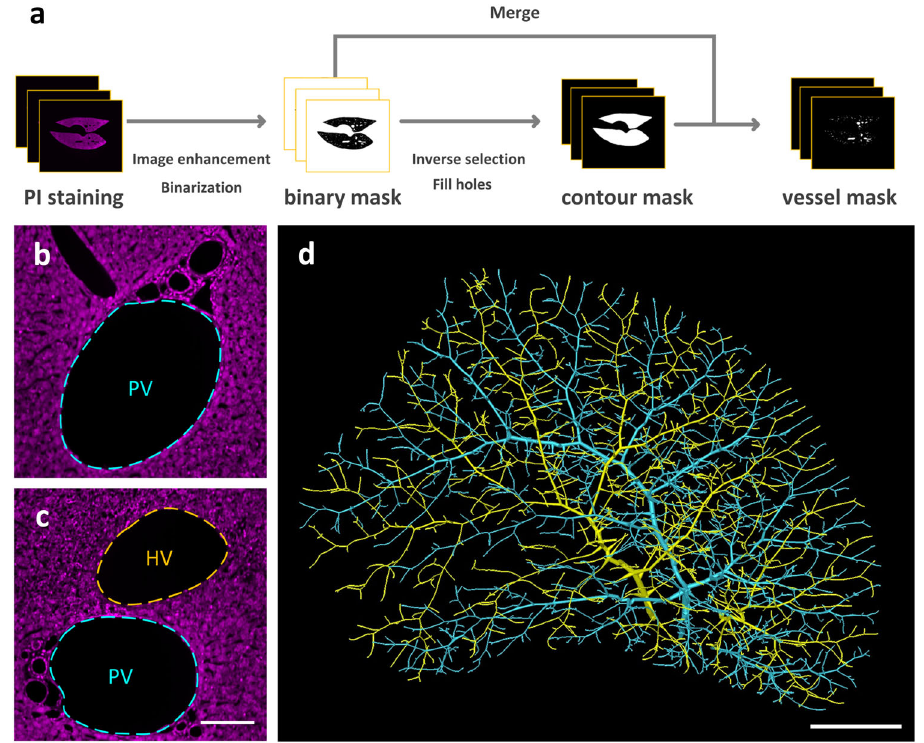
Fig. 2 Reconstruction of the portal vein and hepatic vein. a The reconstruction pipeline. b , c The cytoarchitecture channel images of the local areas in the liver. The portal vein and hepatic vein are respectively marked with cyan and yellow dashed lines. d 3D reconstruction of the portal vein and hepatic vein. The portal vein is marked with cyan. The hepatic vein is marked with yellow. PV portal vein, HV hepatic vein. Scale bar, b , c 50 μ m; d 1